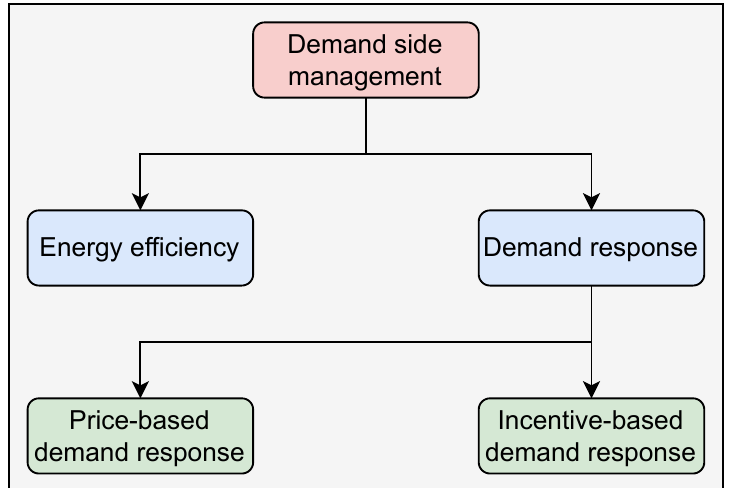
Figure 2. Demand-side